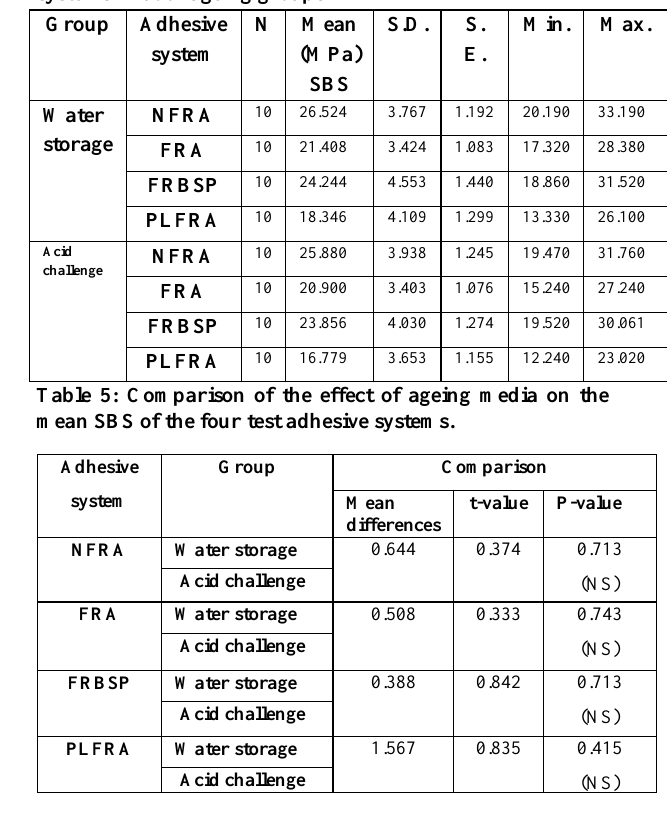
Table 6: Comparison of the effect of ageing media on the ARI scores distribution of the four test adhesive